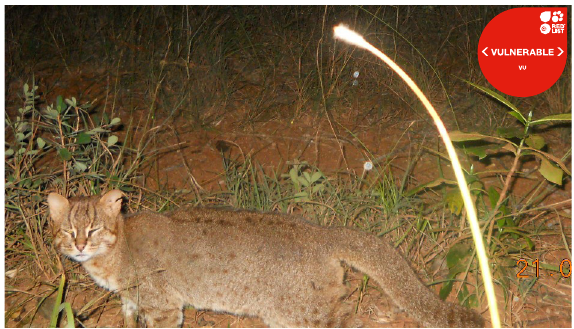
Image 7. Rusty-spotted Cat Prionalilurus rubiginosus